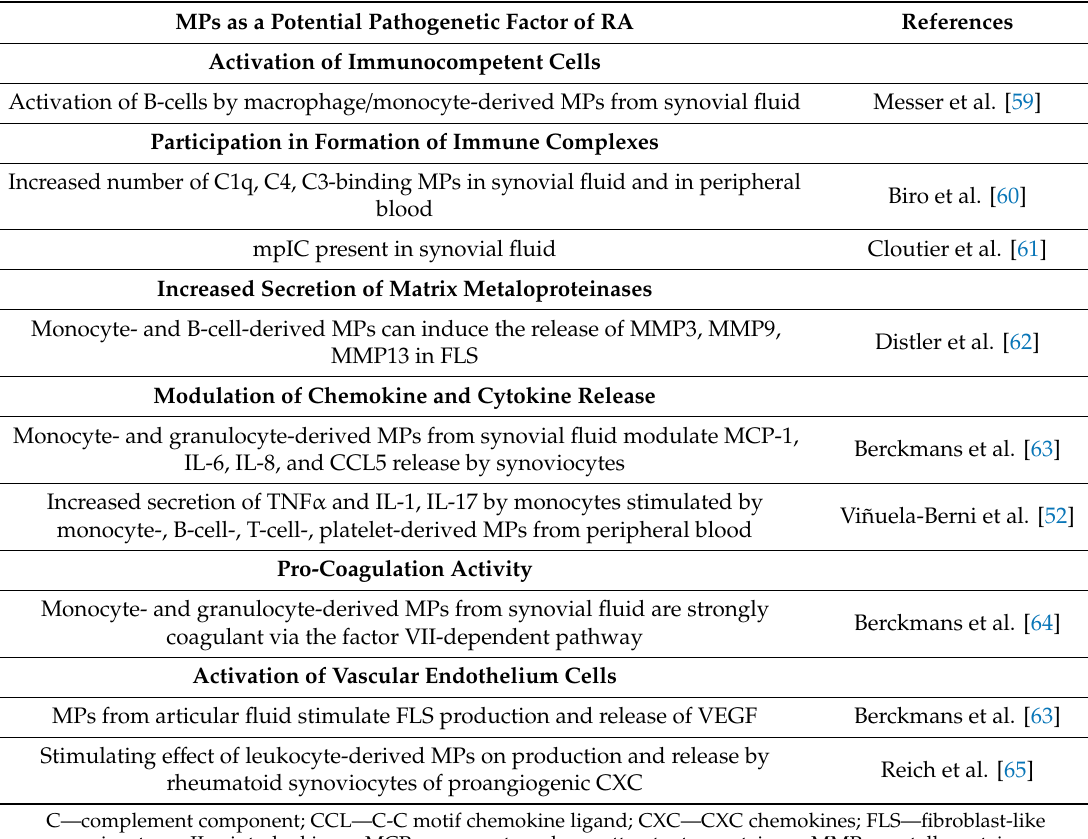
Table 3. Potential role of microparticles in the development of rheumatoid arthritis. MPs as a Potential Pathogenetic Factor of